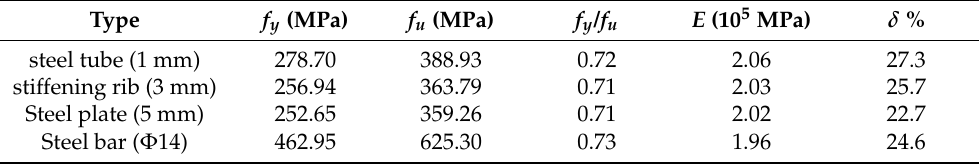
Table 3. Steel material Figure 2. Displacement meter and strain gauge arrangement. ( a ) External concrete ( b ) Steel pipe